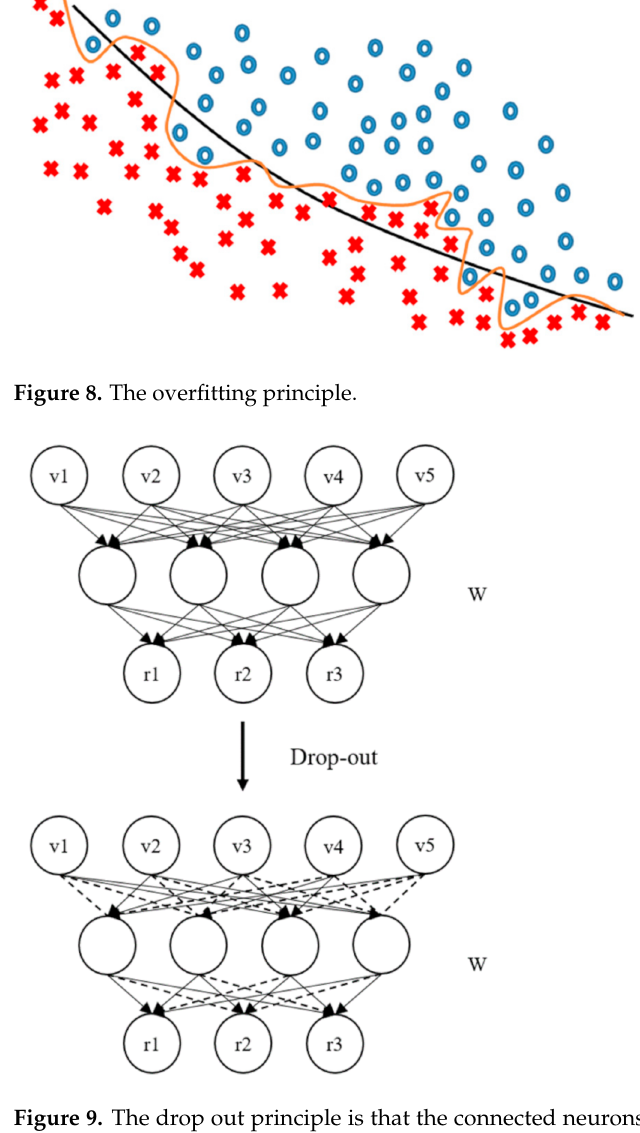
Figure 9. The drop out principle is that the connected neurons are randomly selected and discon- nected, eliminating adaptability between neurons during